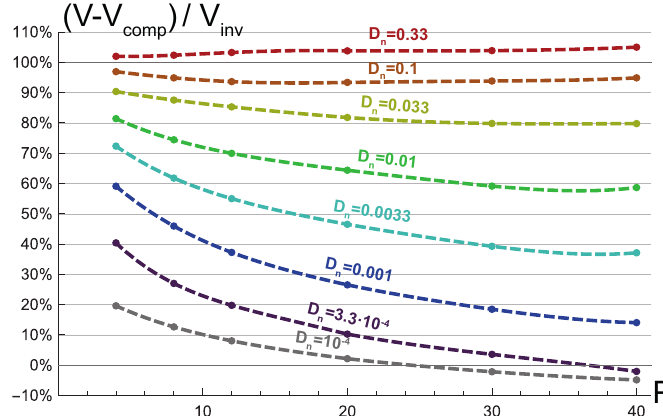
Figure 6. The dots denote the ratios of the differences of tumor growth speed V and V comp , which is the growth speed of the same tumor under zero cell motility, to V inv , which is the growth speed of the same tumor under the neglect of convective flows. All values were obtained numerically in the simulations of Equation (1) with space step h = 0.01 and time step τ = 10 − 4 under designated values of angiogenesis parameter P and tumor cell motility D n and the values of other parameters taken from the basic set. The dashed lines are interpolations of data